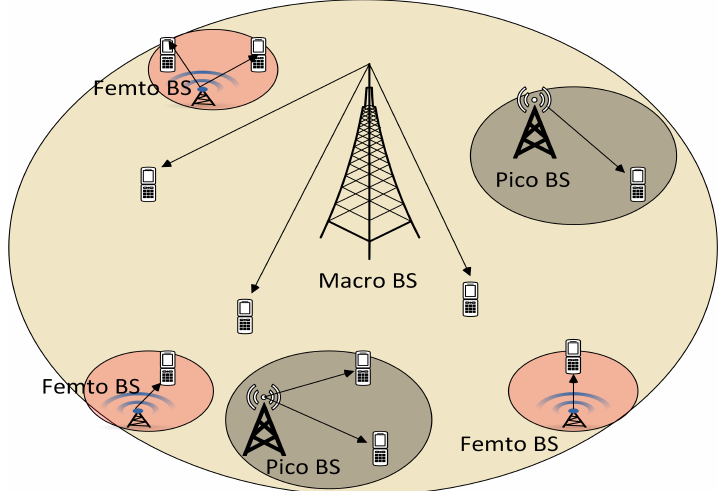
Figure 1. Heterogeneous radio access network (RAN) system